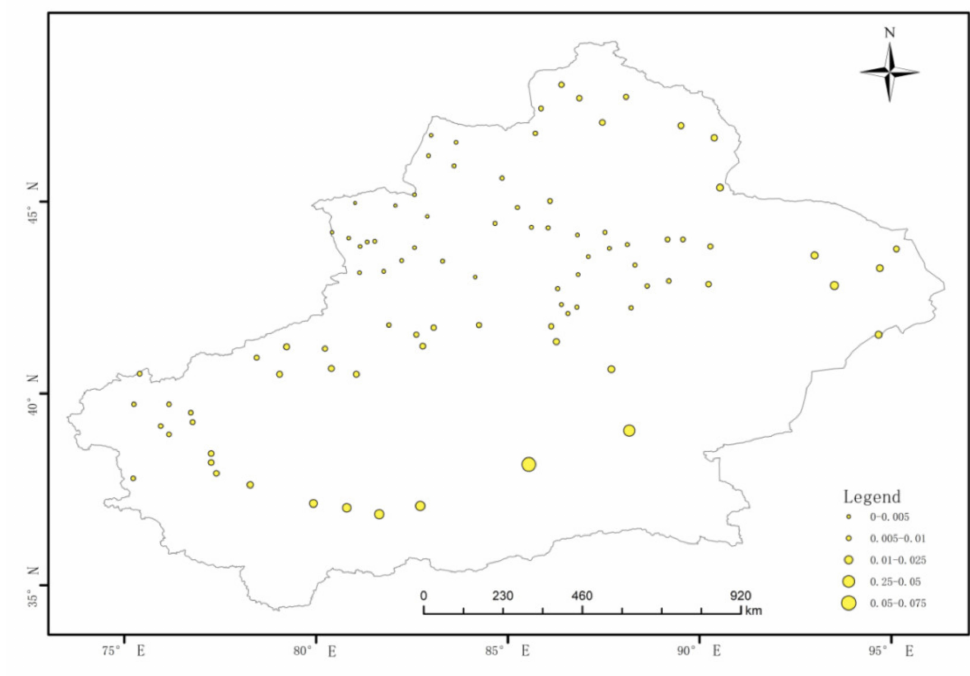
Figure 5. Weight coefficients distribution of the 89 stations in Xinjiang